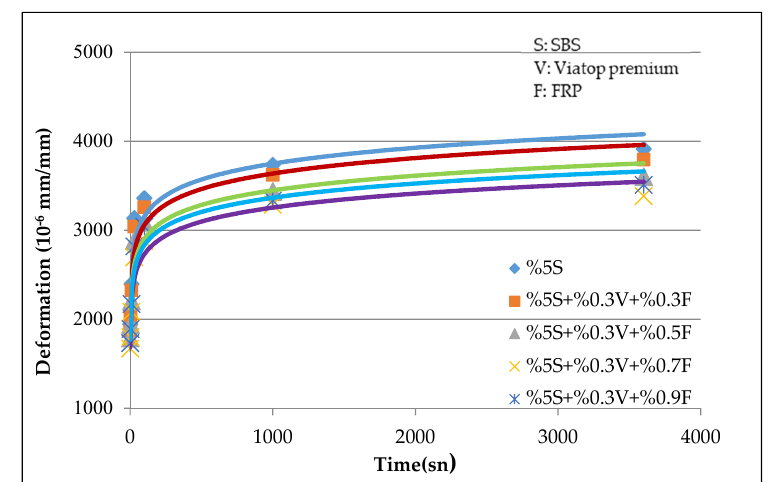
Figure 10. Variation of creep deformation over time. Fibers 2020 , 8 , x FOR PEER REVIEW